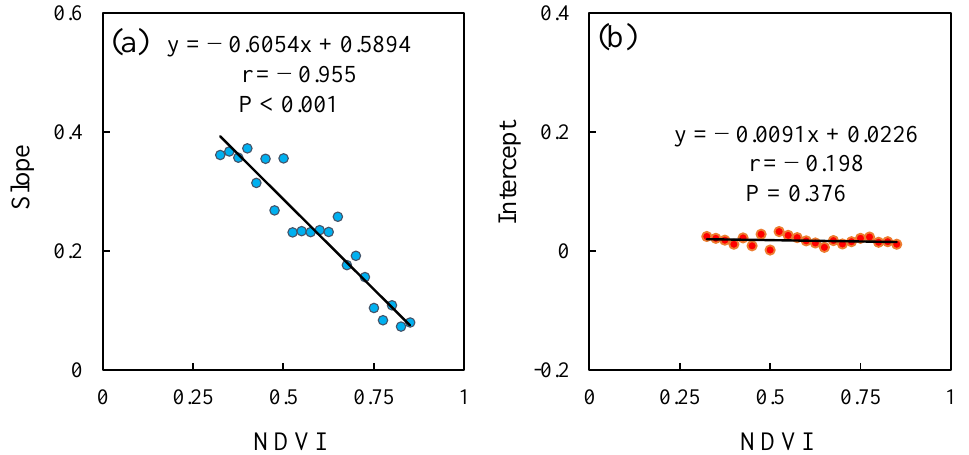
Figure 4. Relationship between TOA reflectances at 1.6 μm and surface reflectance at 0.67 μm as a function of NDVI: ( a ) slopes (for each scatter plot in Figure 3 with given NDVI values) as a function of NDVI; and ( b ) intercepts as a function of NDVI.